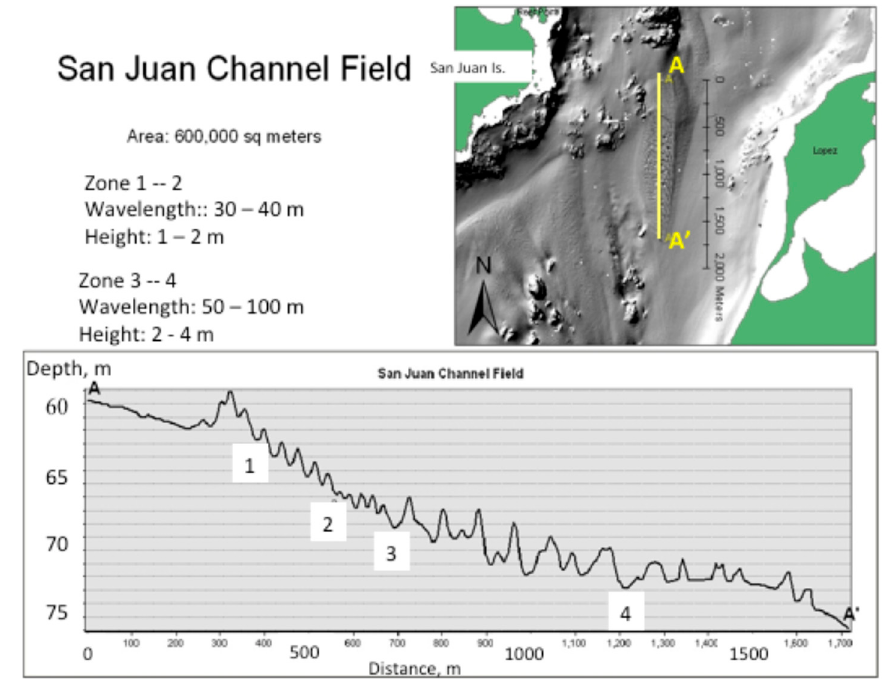
Figure 12. MBES bathymetric imagery and cross-section (A-A’) of the San Juan Channel sand wave field showing two different sections (1–2 and 3–4) of sediment waves of differing sizes.